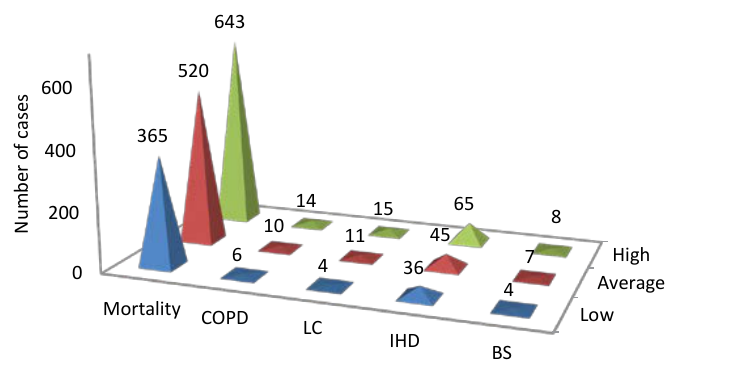
Figure. 3. Estimated attributable cases of mortality and diseases